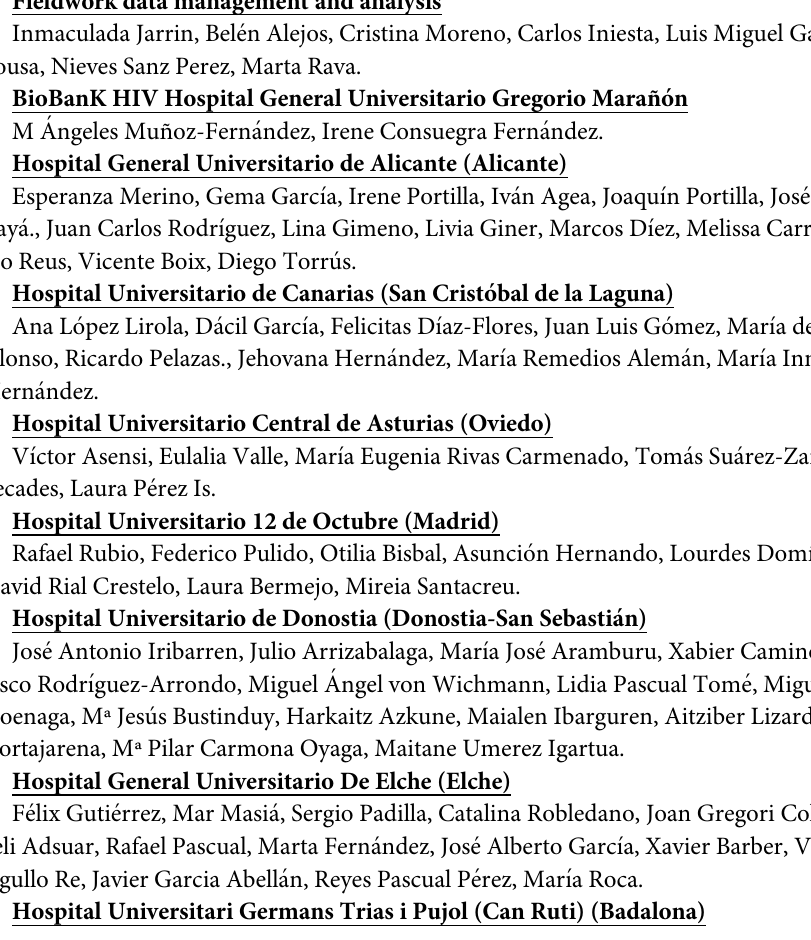
S4 Table. Impact of late presentation and late presentation with advanced disease on the composite endpoint, first ADE, first SNAE and overall mortality when late presentation and late presentation with advanced disease are defined as participants with an HIV-diag- nosis at a CD4 < 350 cells/ μ L (or < 200 cells/ μ L for advanced disease) or with an AIDS- defining event within the 4, 12 or 48 weeks after enrolment S4 Table. Impact of late presen- tation and late presentation with advanced disease on the composite endpoint, first AIDS event, first serious non-AIDS event and overall mortality when late presentation and late pre- sentation with advanced disease are defined as participants with an HIV-diagnosis at a CD4 < 350 cells/ μ L (or < 200 cells/ μ L for advanced disease) or with an AIDS-defining event within the 4, 12 or 48 weeks after